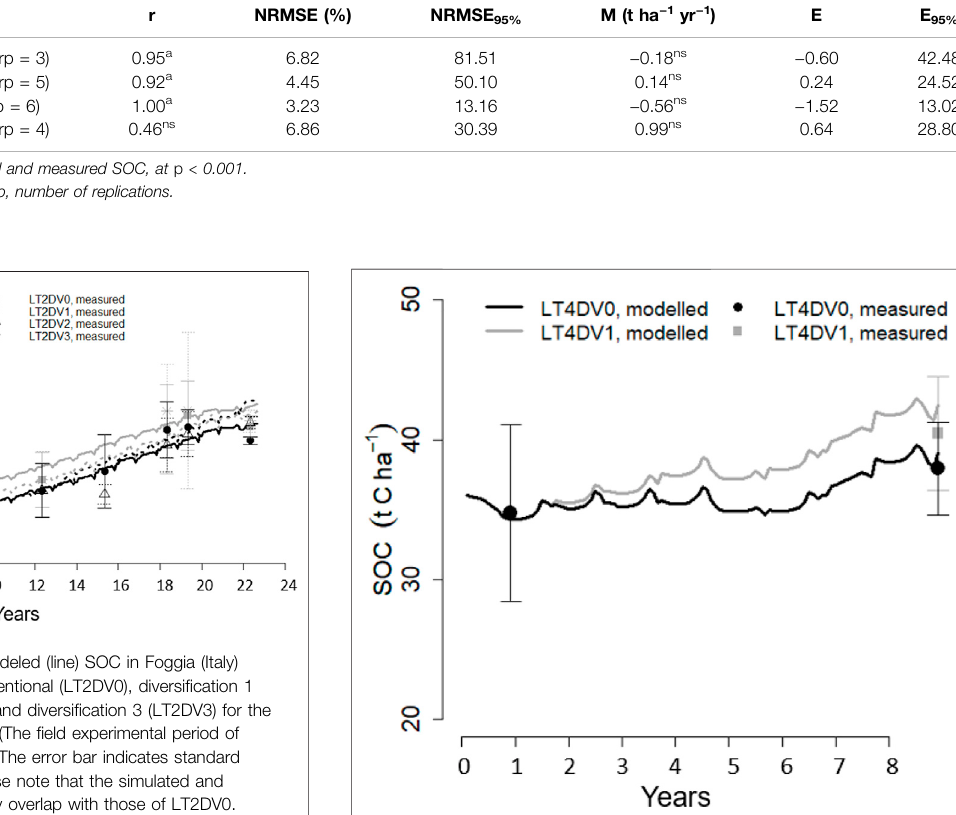
FIGURE 5 | Measured (point) and modeled (line) SOC in Huesca (Spain) cereal cropland site, LT4, under conventional (LT4DV0), and diversi fi